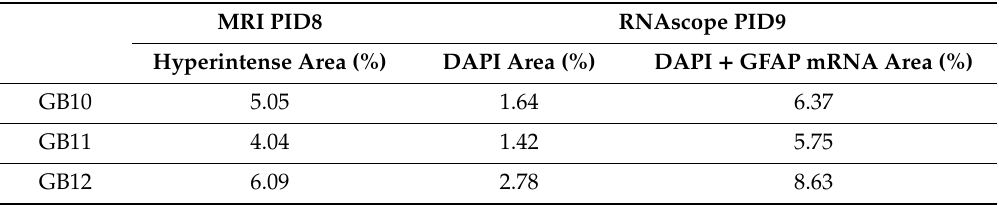
Table 3. MRI vs. RNAscope. This table summarizes the di ff erent relative areas calculated on MRI and RNAscope images. We can see that hyperintense areas on MRI extend beyond strongly DAPI-stained areas on RNAscope, but are smaller than areas including a high level of GFAP mRNA on